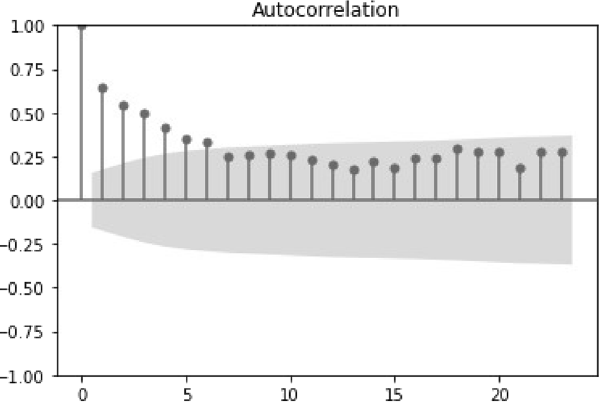
Figure 6. Autocorrelation plot for the time series of the weekly deceased donors.